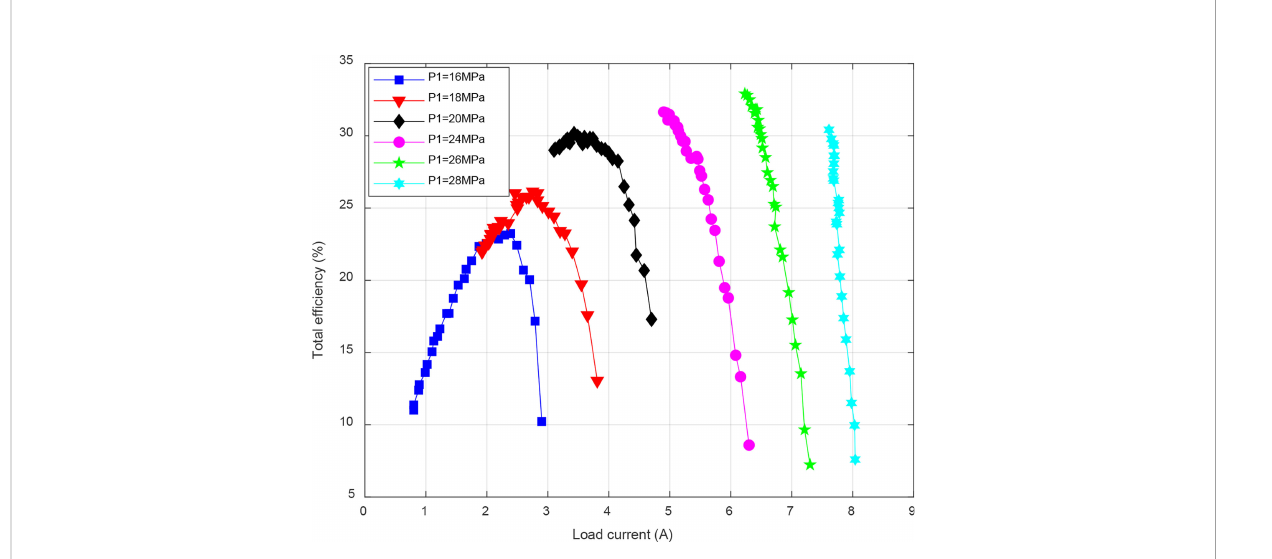
FIGURE 7 The total ef fi ciency of the energy conversion system.